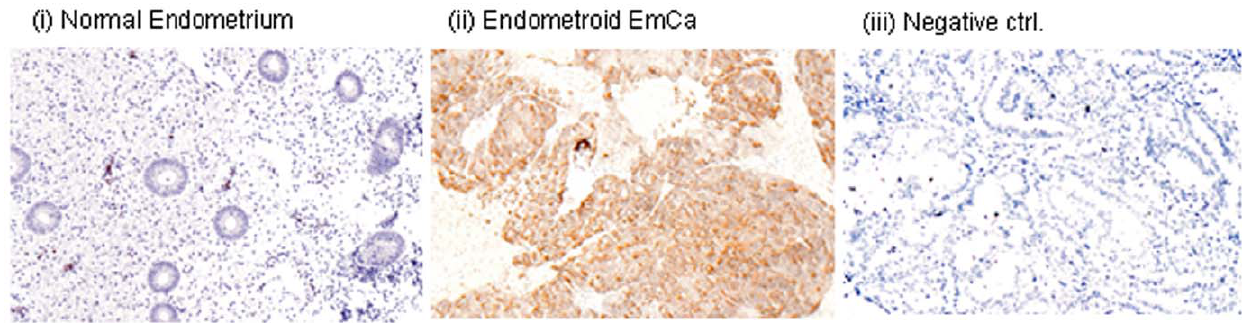
Figure 4. Immunohistochemistry of S100A6 protein in EmCa tissues and normal endometrium . Immunohistochemical analysis of S100A6 protein was carried out in independent paraffin-embedded tissue sections of endometrial cancer and normal endometrium (n=5 each) as described in Materials and Methods. Panel shows (a) no immunostaining of S100A6 protein in normal endometrium; (b) endometrial cancer showing cytoplasmic expression of S100A6 protein; and (c) negative control showing no expression of S100A6 protein.